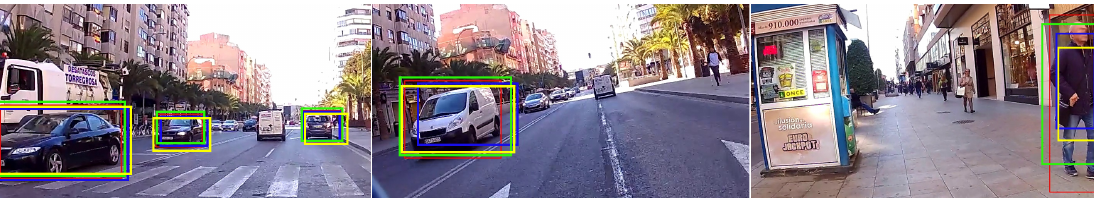
Figure 16. Examples of tracked objects related to YOLOv2 detection, skipping 3, 7 and 11 frames.